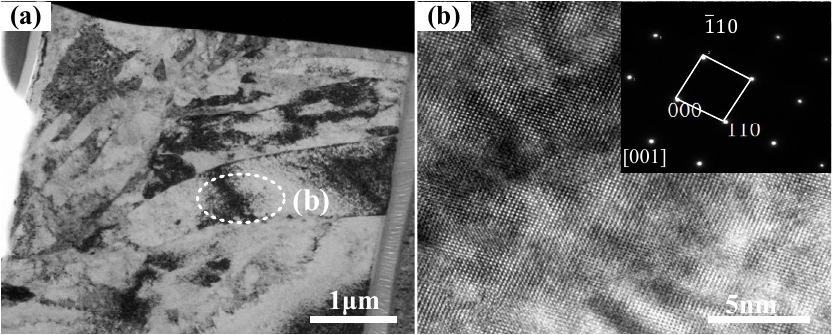
Figure 8. TEM of FeCrNiMoRE cladding layer: ( a ) Microstructure of the cladding layer; ( b ) High resolution image along the (001) direction.